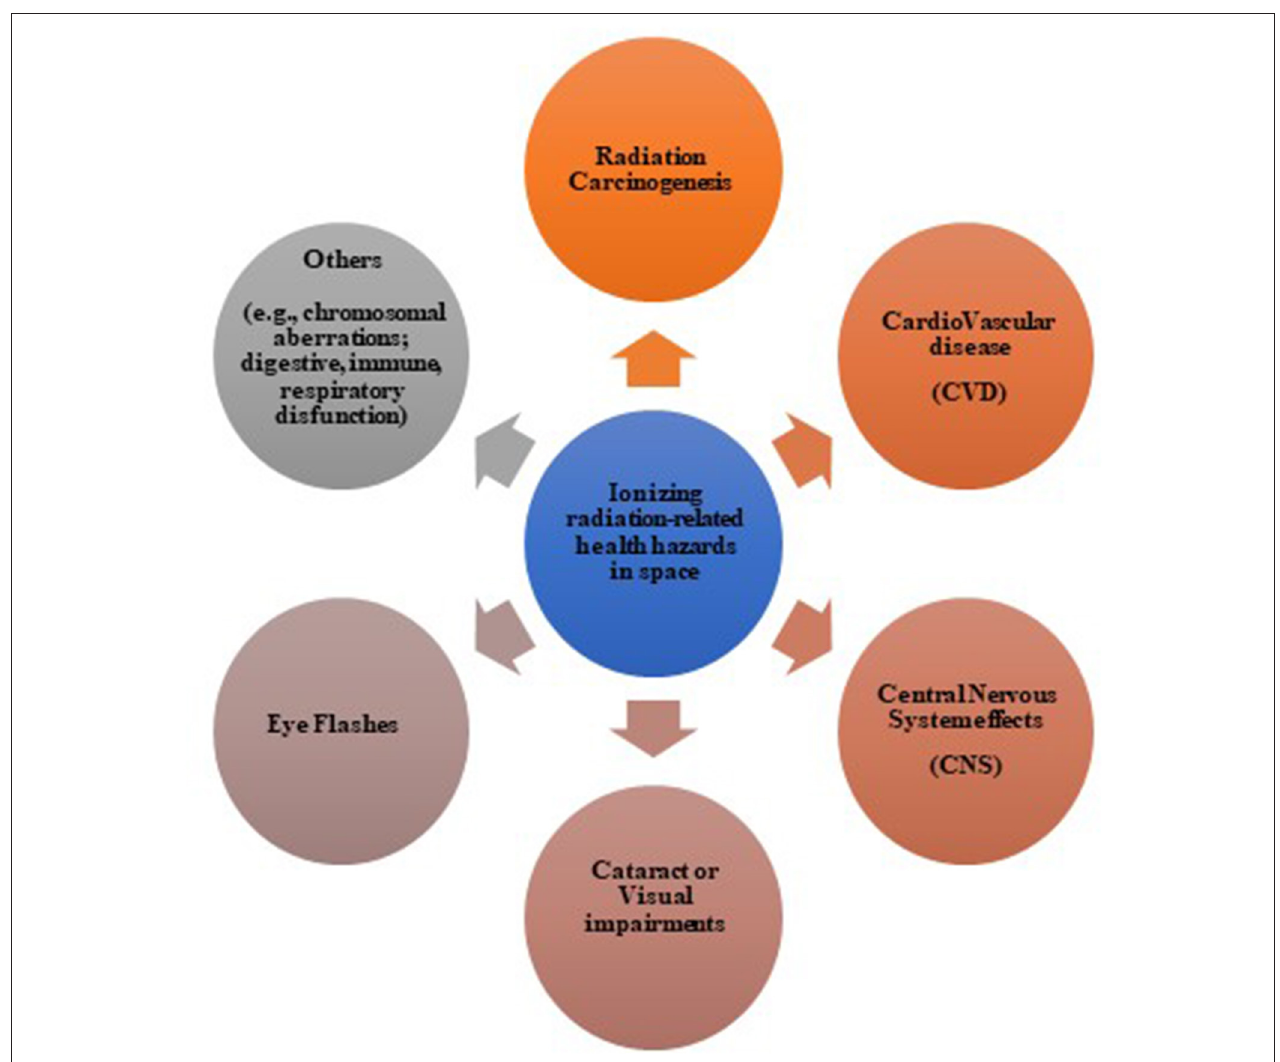
FIGURE 2 | Possible ionizing radiation-related health hazards in